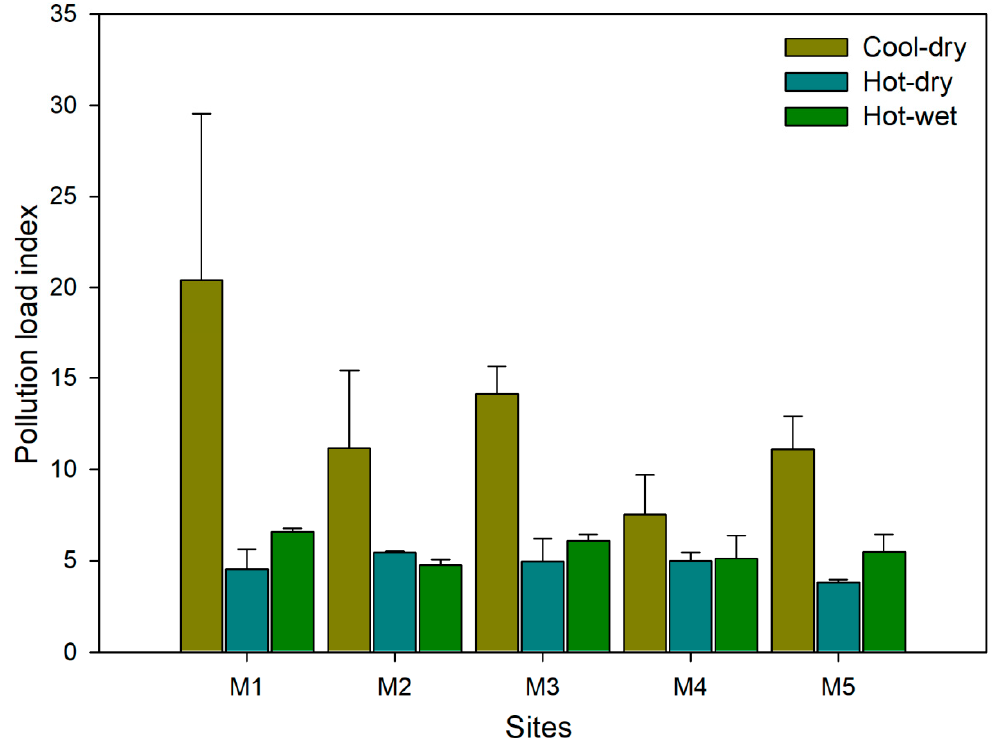
Figure 1. Mean Pollution load indices ( ± standard error) recorded across five sites (M1–M5) and three seasons (cool-dry, hot-dry, hot-wet) based sediment metal concentrations for the Mvudi River, South Africa.